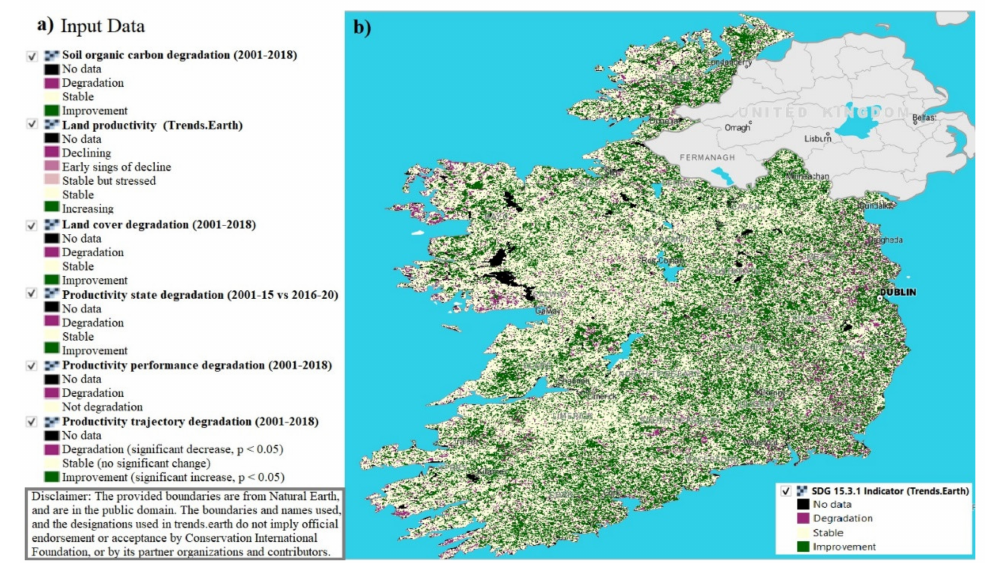
Figure 4. ( a ) Input Data for the estimation of the SDG15.3.1 (the disclaimer refers to the use of data from Natural Earth repository [44]). ( b ) The output map with the results of SDG15.3.1. Note: Northern Ireland is under a separate jurisdiction to the Republic of Ireland; thus, its data are not shown in the